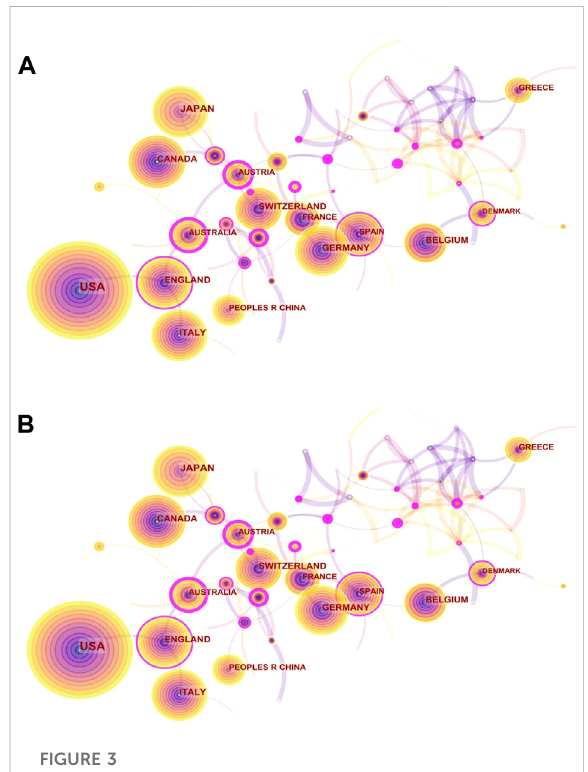
FIGURE 3 Visual network diagram of country and institution. (A) Country map of the denosumab study in 2011 – 2021. Nodes represent countries or regions, and lines represent cooperation. The colored rings in the nodes represent different years, and the purple outer circle represents higher centrality. (B) Network mapofinstitutional cooperationindenosumabfrom 2011to 2021. Nodes represent institutions, and lines represent cooperation. Colors in the nodes represent different years. The circle area represents the publication volume, and the purple outer circle represents higher centrality.